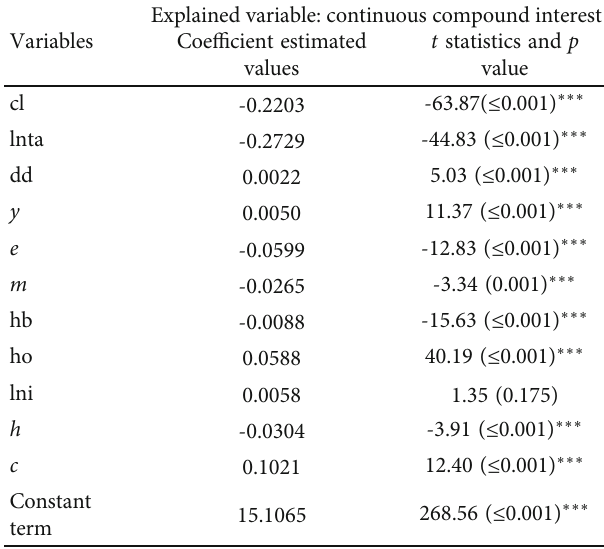
Table 5: In fl uencing factors of continuous compound